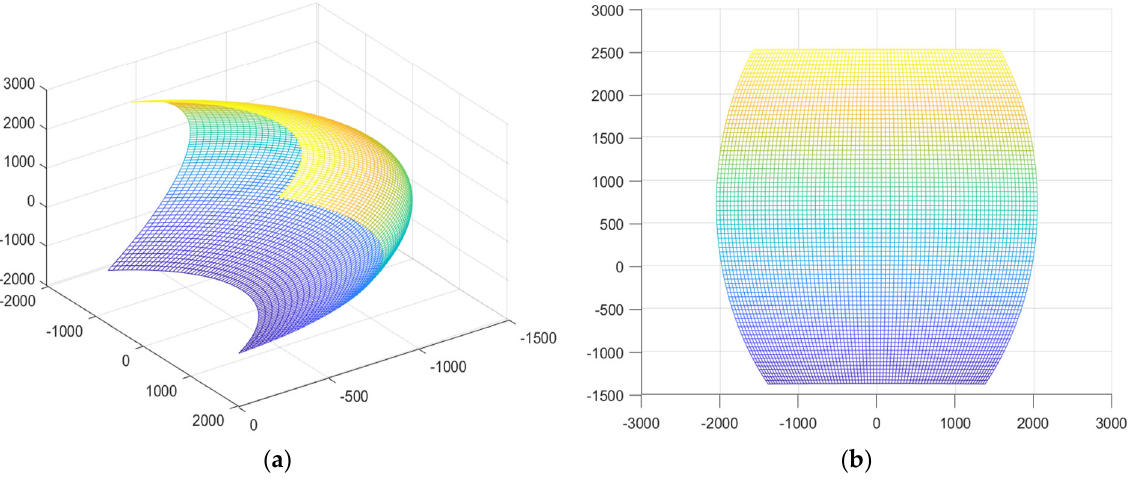
Figure 8. Simulation diagram of limit cutting section of the cutting head (d = 500 mm). ( a ) Three ‐ dimensional simulation diagram of cutting section. ( b ) Projection of cutting section on YOZ plane.